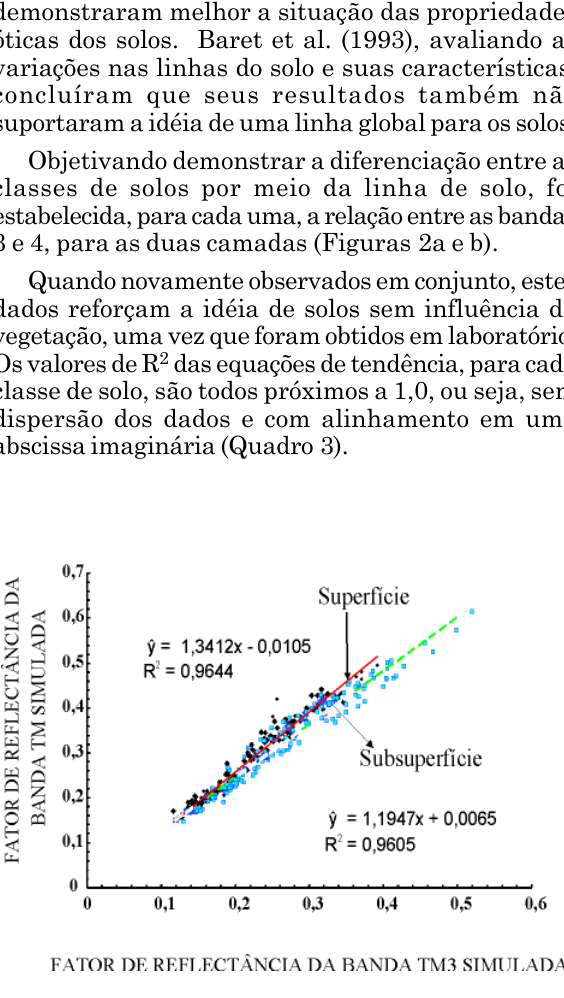
Figura 1. Linha do solo das amostras de superfície e subsuperfície obtida pela relação da reflectância entre as bandas 3 e 4 simuladas para as faixas do sensor TM, com os dados obtidos em